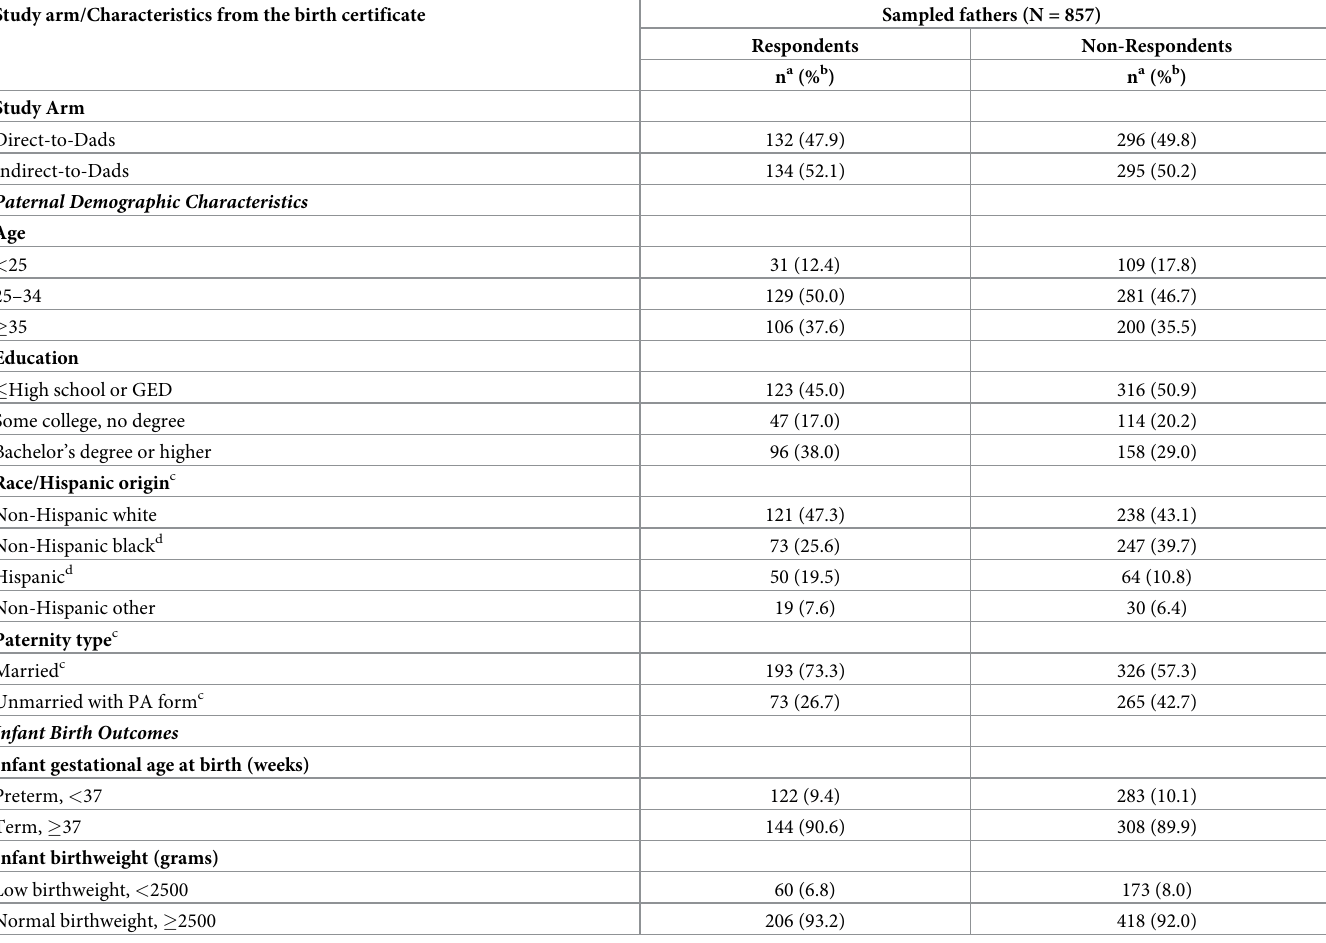
Abbreviations: PA = Paternity Acknowledgement, GED = General Educational Development. a Unweighted sample size; sample size may vary due to missing. b Weighted percentage. Father analysis weight is his sampling weight.